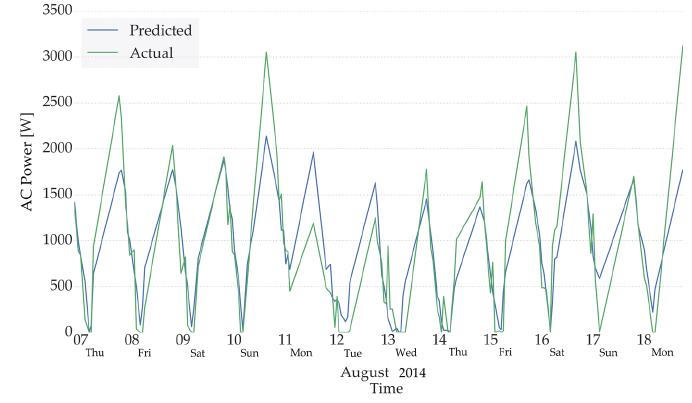
Figure 7. Day-ahead predictions using Random Forest Decision Tree.